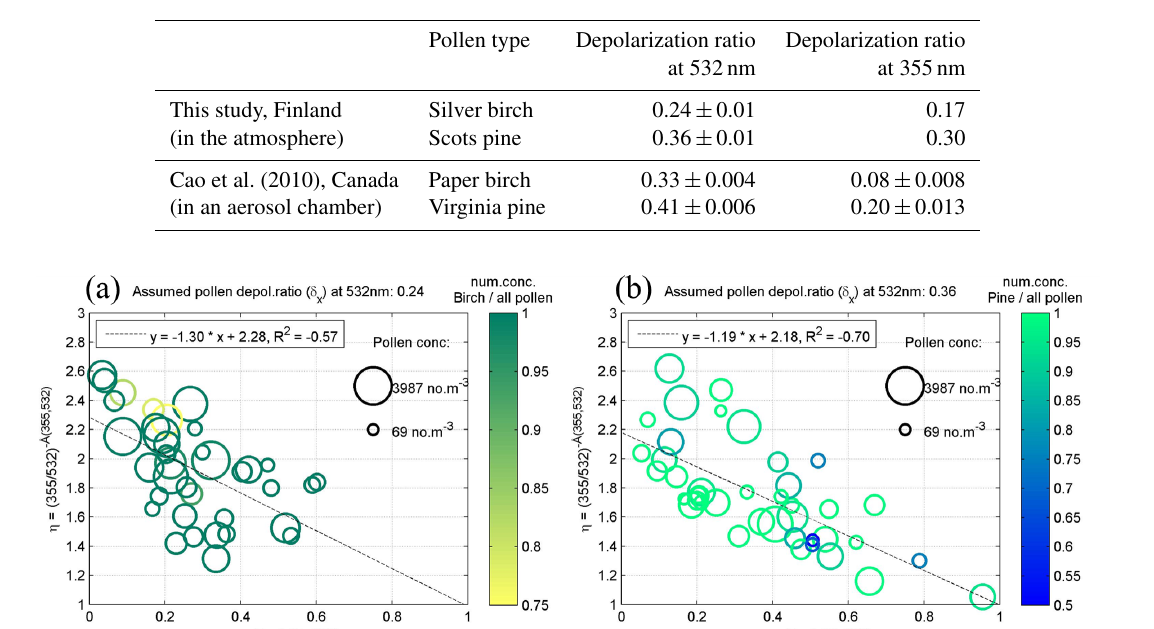
Table 5. Linear depolarization ratios for pure pollen. The assumption that the backscatter-related Ångström exponent between 355 and 532nm for pollen ( Å pollen ) should be 0 was applied for this study. The uncertainty on Å pollen was not taken into account for the standard deviation shown here, which may introduce non-negligible additional bias. For example, under the assumption of Å pollen ± 0.5, the range of depolarization ratio values is 0.19 to 0.27 for birch pollen and 0.26 to 0.44 for pine pollen. See more details in Sect. 4.3.